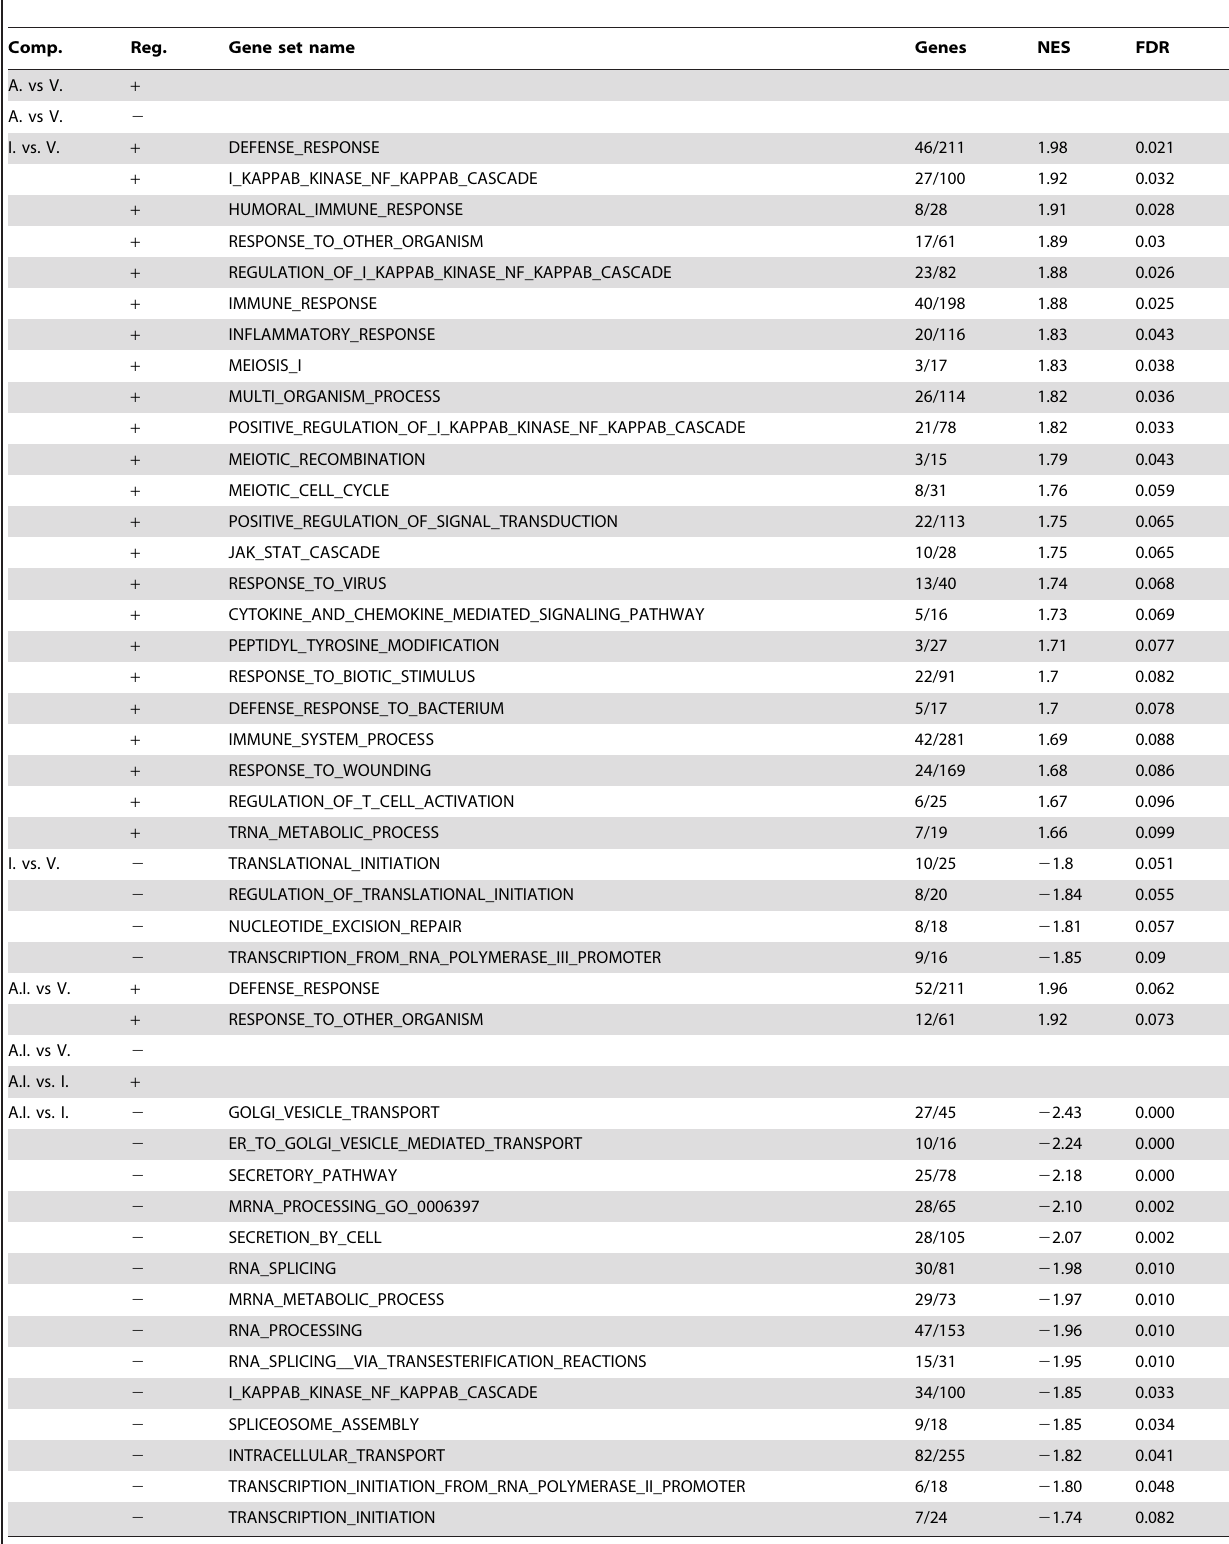
Table 5. Gene Set Enrichment Analysis.